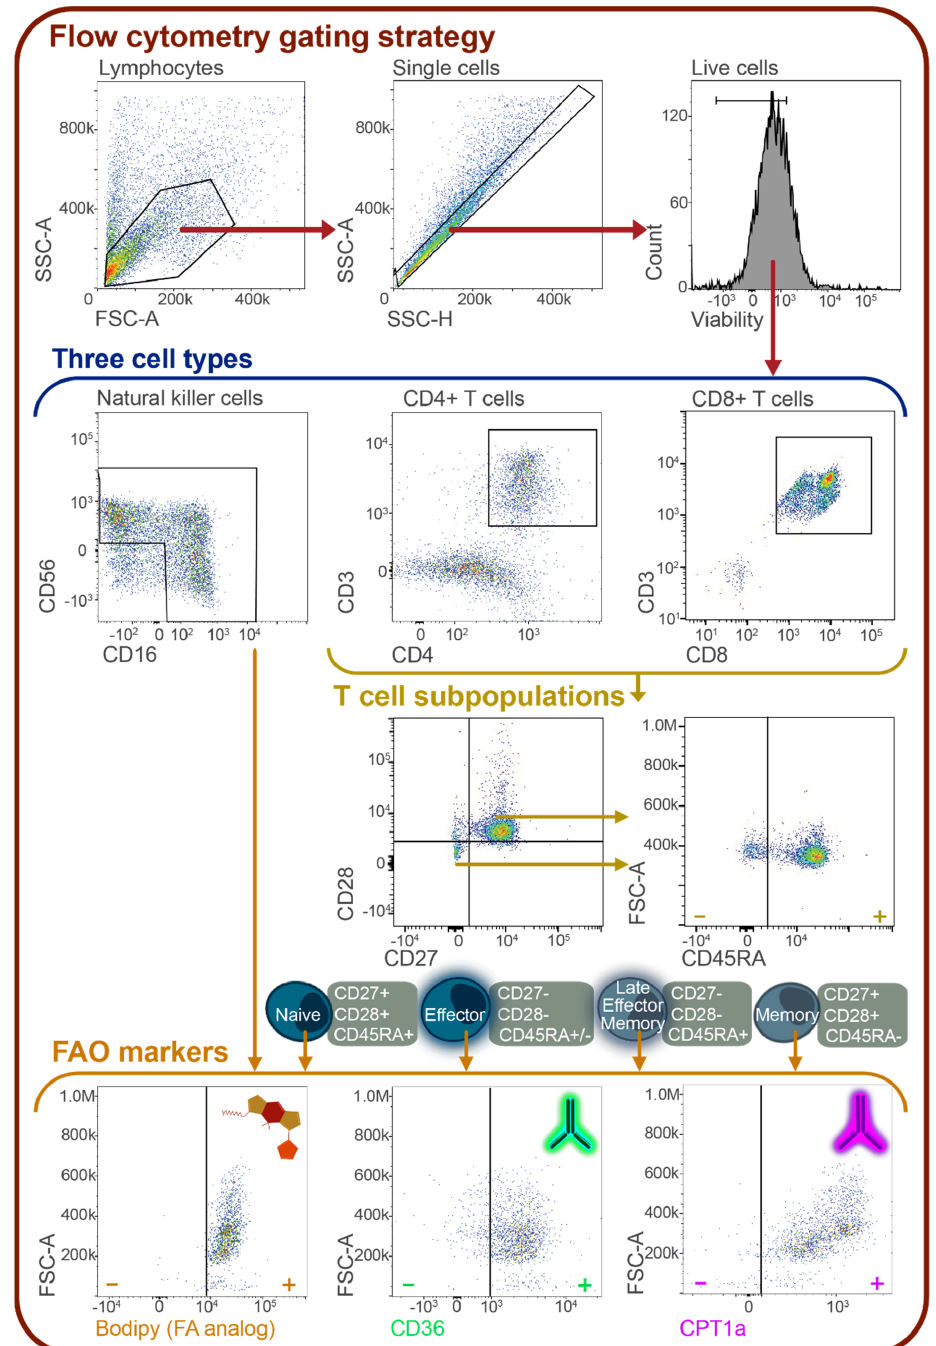
Figure 3. Flow cytometric cell population gating strategy for T and NK cells. All cells were gated by size, granularity, and viability using FSC-A, SSC-A, SSC-H, and eBiosciences Fixable Viability Dye eFluor 506. Isolated NK cells were gated to include CD56+CD16+, CD56+CD16-, and CD56- CD16+ cells. CD4+ T cells were gated for naïve (CD27+CD28+CD45RA+), effector (CD27-CD28- CD45RA+/-), late effector memory (CD27-CD28-CD45RA+), and memory (CD27+CD28+CD45RA-) cell populations, based on prior studies using these markers for cell population identification [65–67]. The same populations were identified in CD8+ T cells. Within each of these populations and in total CD8+ and CD4+ T cells, the mean and median fluorescence intensity (MFI) of BODIPY 558/568 C12, CPT1a, and CD36 were calculated. Specific antibodies and fluorophores used can be found in Supplementary Table